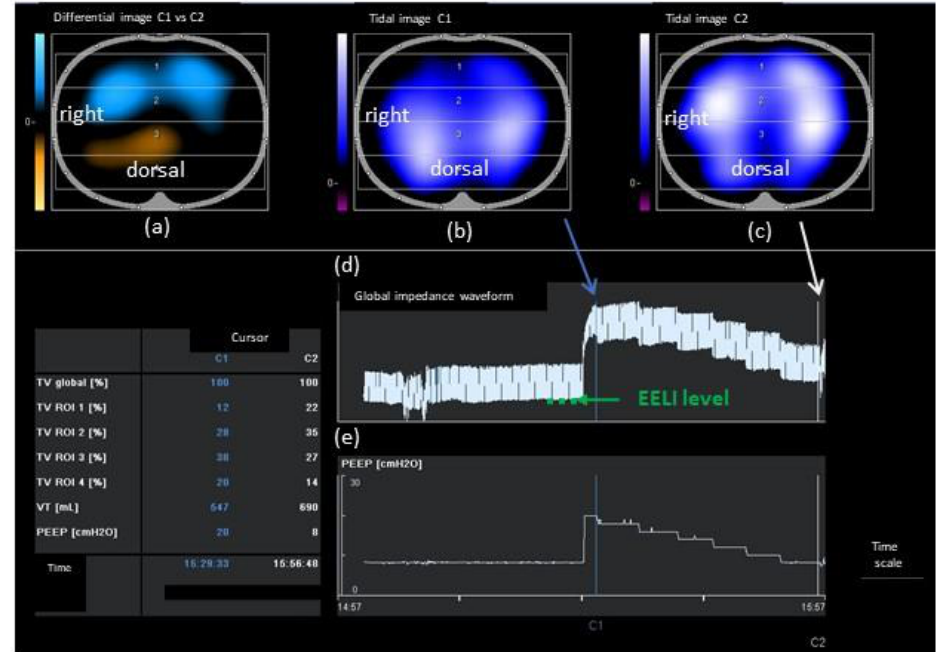
Figure 1. An example of EIT online analysis. ( a ) Differential image between PEEP 8 cmH 2 O and PEEP 20 cmH 2 O, defined as the reference. Regional differences are displayed as color-coded images, with blue indicating increases, and orange indicating decreases, compared with reference data. ( b ) Tidal image at PEEP 20 cmH 2 O. Regional ventilations are displayed as color-coded images. Bright-colored regions (corresponding to large impedance) represent well-ventilated areas. Dark-colored regions (small impedance change) represent less-ventilated areas. ( c ) Tidal image at PEEP 8 cmH 2 O. ( d ) Global impedance waveform. The dotted line indicates the EELI level. ( e ) PEEP level. EIT, electrical impedance tomography; PEEP, positive end-expiratory pressure; EELI, end-expiratory lung impedance; ROI, region of interest; TV, tidal impedance variation; VT, tidal volume.